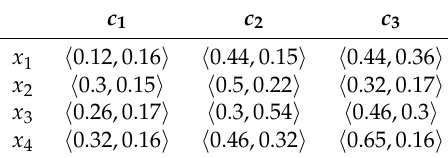
Table 4. R 4 : opinion of expert m 4